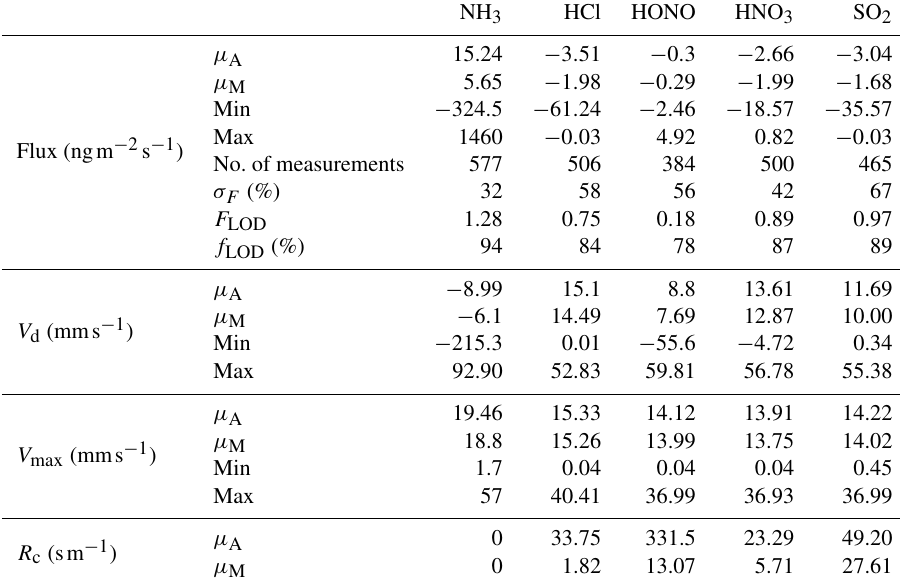
Table 2. Mean ( µ A ), median ( µ M ), minimum and maximum values for flux, deposition velocity ( V d ), maximum deposition velocity ( V max ) and canopy resistances ( R c ) for trace gases measured during the Easter Bush campaign, based on hourly values. Also shown are the median relative standard error ( σ F ), the flux limit of detection ( F LOD ) evaluated for typical conditions (median u ∗ and median concentration) and the fraction of the hourly flux value that exceeds the flux detection limit evaluated for that hour ( f LOD